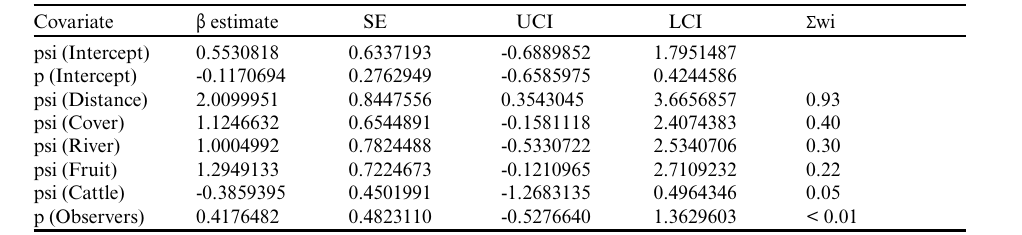
Table 3 . Parameter estimates ( β ) with standard errors (SE), upper (UCI) and lower (LCI) 95% confidence intervals, and summary of Akaike weights of covariates for the average model of Bare- faced Curassow of the Humid Chaco, northern Argentina.